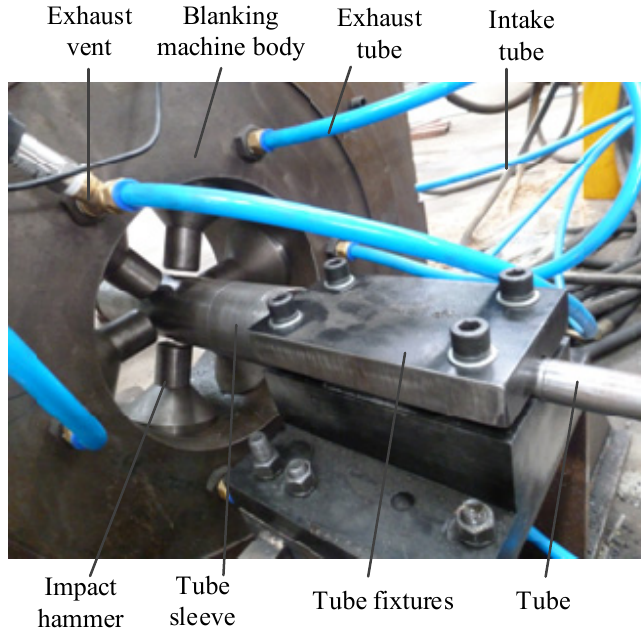
Figure 4. Fatigue impact loading separation test setup. The centerline of the clamping device and the separation device are at the same level. The load arm of the tube sleeve is lengthened, which increases the bending moment. The tube sleeve is placed between the separation device and the clamping device. The sleeve bracket of elastic material is installed inside the tube for fixed installation. Among them, the damping effect of the elastic material enables the tube sleeve to automatically reset after each load. The reduced diameter piston rod forms an independent retraction cavity and feed cavity in each cylinder. Combined with independent intake and exhaust circuits, the feeding and retracting of the hammer head is completed. Therefore, the adjustment of the working air pressure is equal to the adjustment of the impact load. The geometrical parameters of the experimental tube are shown in Figure 5, including the tube separation length L1, the outer diameter D of the tube, the inner diameter d and the geometric parameters of the notch. In the tube separation experiment, the stress concentration groove on the tube surface adopts the annular V-notch. The geometric parameters of annular V-notch include notch flare angle α , notch depth h and notch root base angle radius ρ .